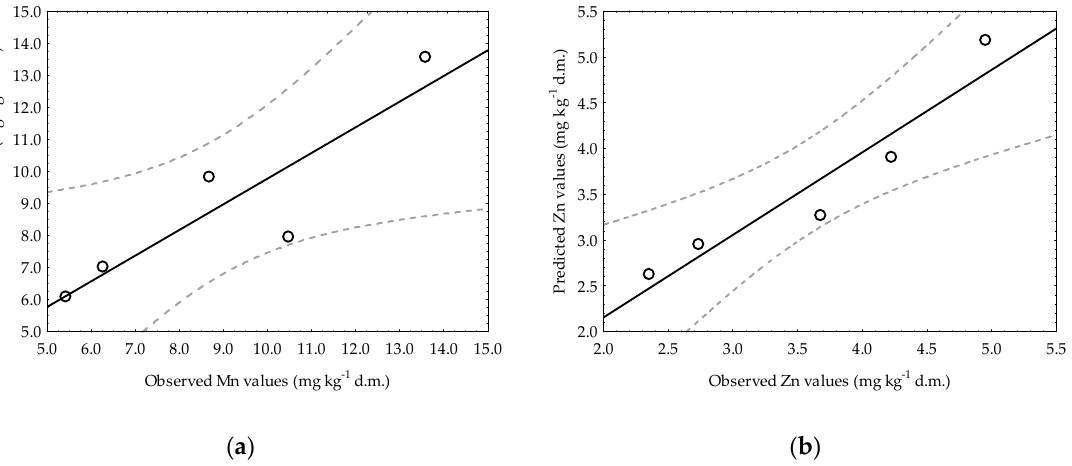
Figure 6. Observed versus predicted plots of linear regression models of Mn ( a ) and Zn ( b ) content changes over time in heavy soil for SI treatment (Mn) and SII treatment (Zn); these experimental combinations were chosen because they had the highest R 2 values (R 2 = 0.8012 for Mn and R 2 = 0.9020 for Zn).